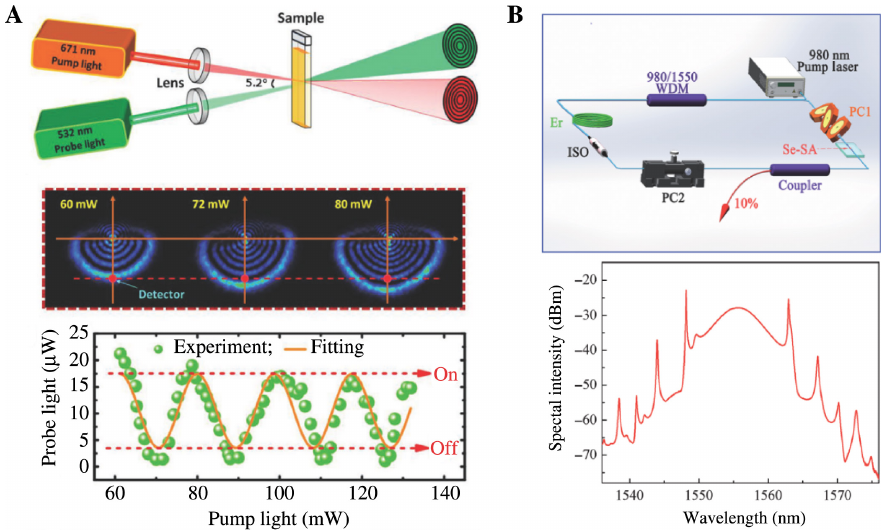
Figure 14: The performance of tellurene- and selenene-based photonic devices. (A) The achieved ON/OFF modes in the all-optical light-modulate-light system based on 2D Te Ns dispersions and spatial cross-phase modulation. Reproduced with permission [177]. Copyright 2019, John Wiley and Sons. (B) Schematic setup of the mode-locked fiber laser with Se-SA and typical laser output pulse optical spectrum. Reproduced with permission [163]. Copyright 2017, John Wiley and